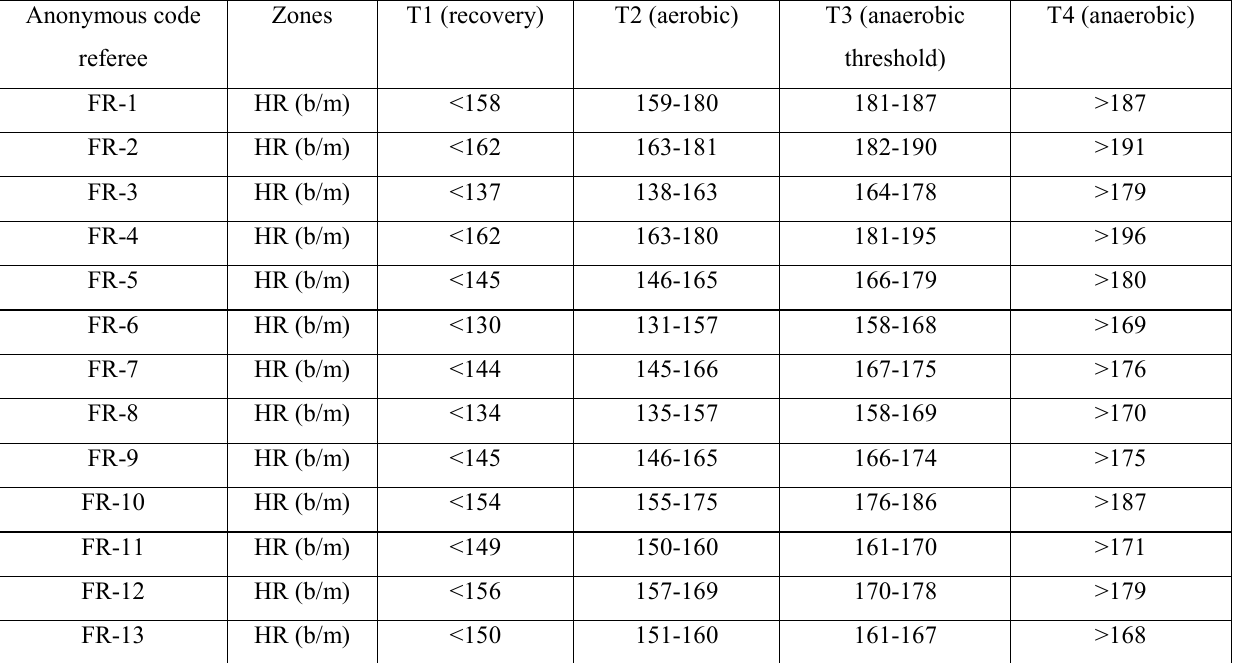
Zones of pulse values of highly qualified football